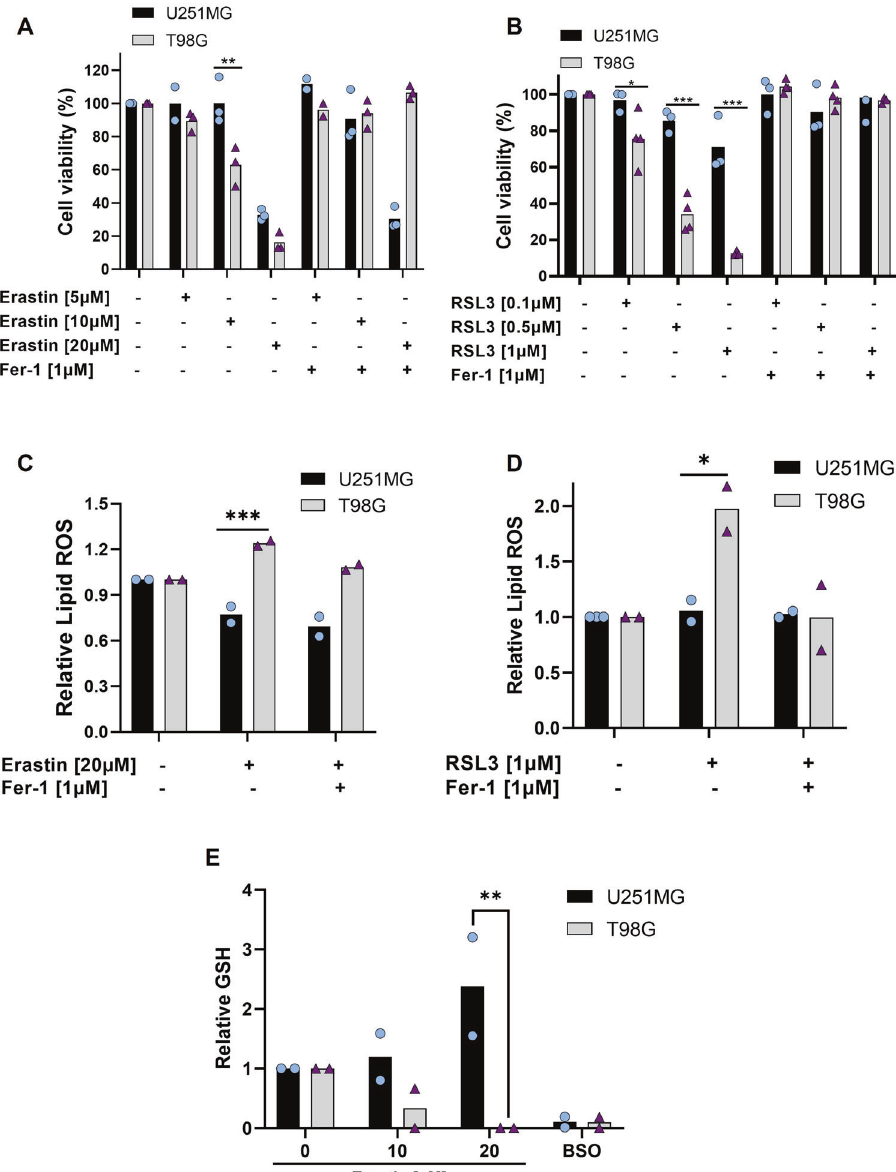
Fig. 3 Differential sensitivity of glioma cells to ferroptosis. A Cells were treated with Erastin (5, 10, and 20 μ M) and Ferrostatin-1 (1 μ M) for 72 h, and cell viability was measured by XTT assay. B Cell viability under another ferroptosis inducer, RSL3 (0.1, 0.5, and 1 μ M), and Ferrostatin-1 (1 μ M) for 72 h was tested by XTT assay. C Cells were treated with Erastin (20 μ M) and Ferrostatin-1 (1 μ M), after 24 h lipid ROS was detected by BODIPY-C11 probe (ratio oxidized/non-oxidized) and analyzed by fl ow cytometry. D Lipid ROS also was measured by the BODIPY-C11 probe (ratio oxidized/non-oxidized) after RSL3 (1 μ M) and Fer-1 (1 μ M) treatment for 24 h. E Intracellular GSH level quanti fi cation after treatment with Erastin (10 and 20 μ M) and BSO (1 mM) for 24 h. Values are mean ± SEM of two or three independent experiments, ns = not statistically signi fi cant, * P < 0.05, ** P < 0.01, *** P < 0.001, **** P < 0.0001. Each dot represents an independent